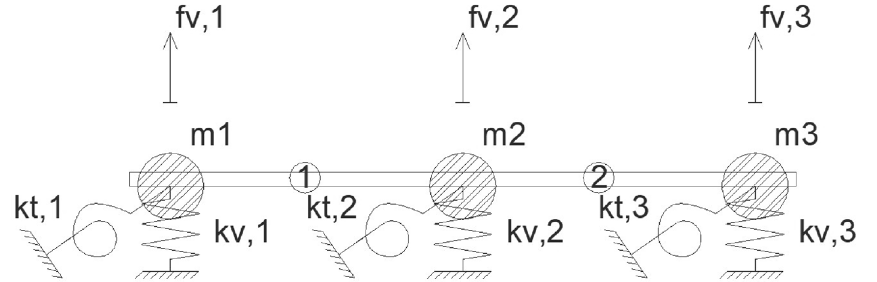
Figure 3. Structural model of concentrated